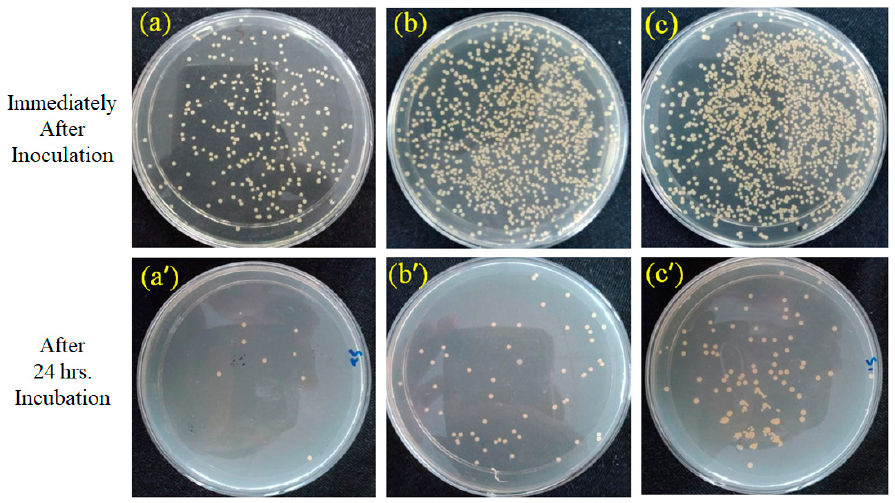
Figure 10. Bacterial colonies immediately after inoculation and after 24 h incubation of ( a , a ′ ) PEO 5% GE 30% , ( b , b ′ ) PEO 5% GE 20% , and ( c , c ′ ) PEO 5% GE 10% . Table 4. Bacterial reduction of the PEO/GE nanomembrane.